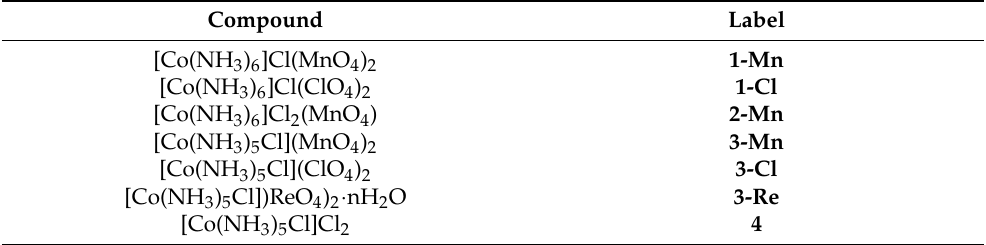
Table 1. Labels of compounds. Compound